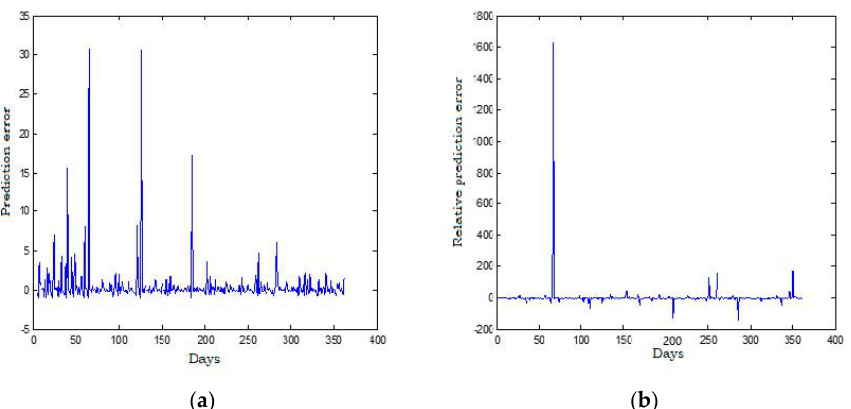
Figure 19. ( a ) Error and ( b ) relative error of the prediction of solar radiation using the ARMA (4,4) model. Table 9. Prediction errors of solar radiation using the ARMA (4,4) model. Errors